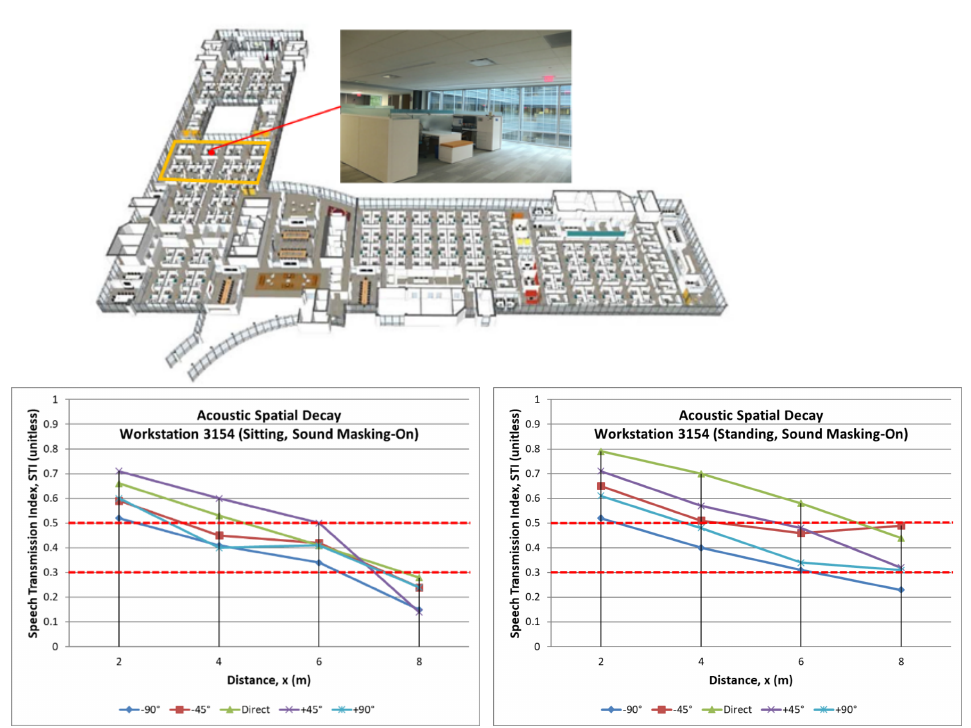
Figure 3. Office map depicting location on the third floor, north wing, at which measurements were conducted along with a snapshot of the interior space ( top ). Speech transmission index (STI) as a function of distance at different angles to a sitting speaker ( bottom left ) and a standing speaker ( bottom right ) with sound masking. The red dashed lines indicate a STI target value between 2–4